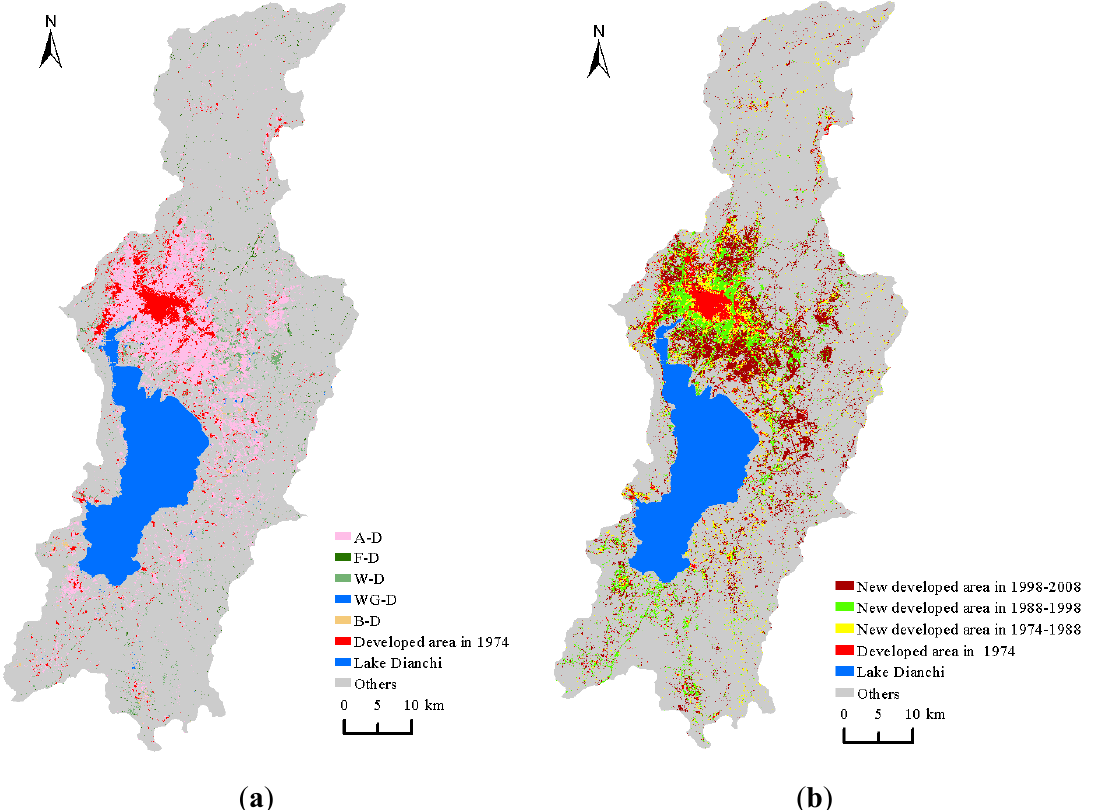
Figure 5. Urban sprawl dynamics in the studied time intervals ( a ) and the transformation of land use types to developed areas from 1974 to 2008 ( b